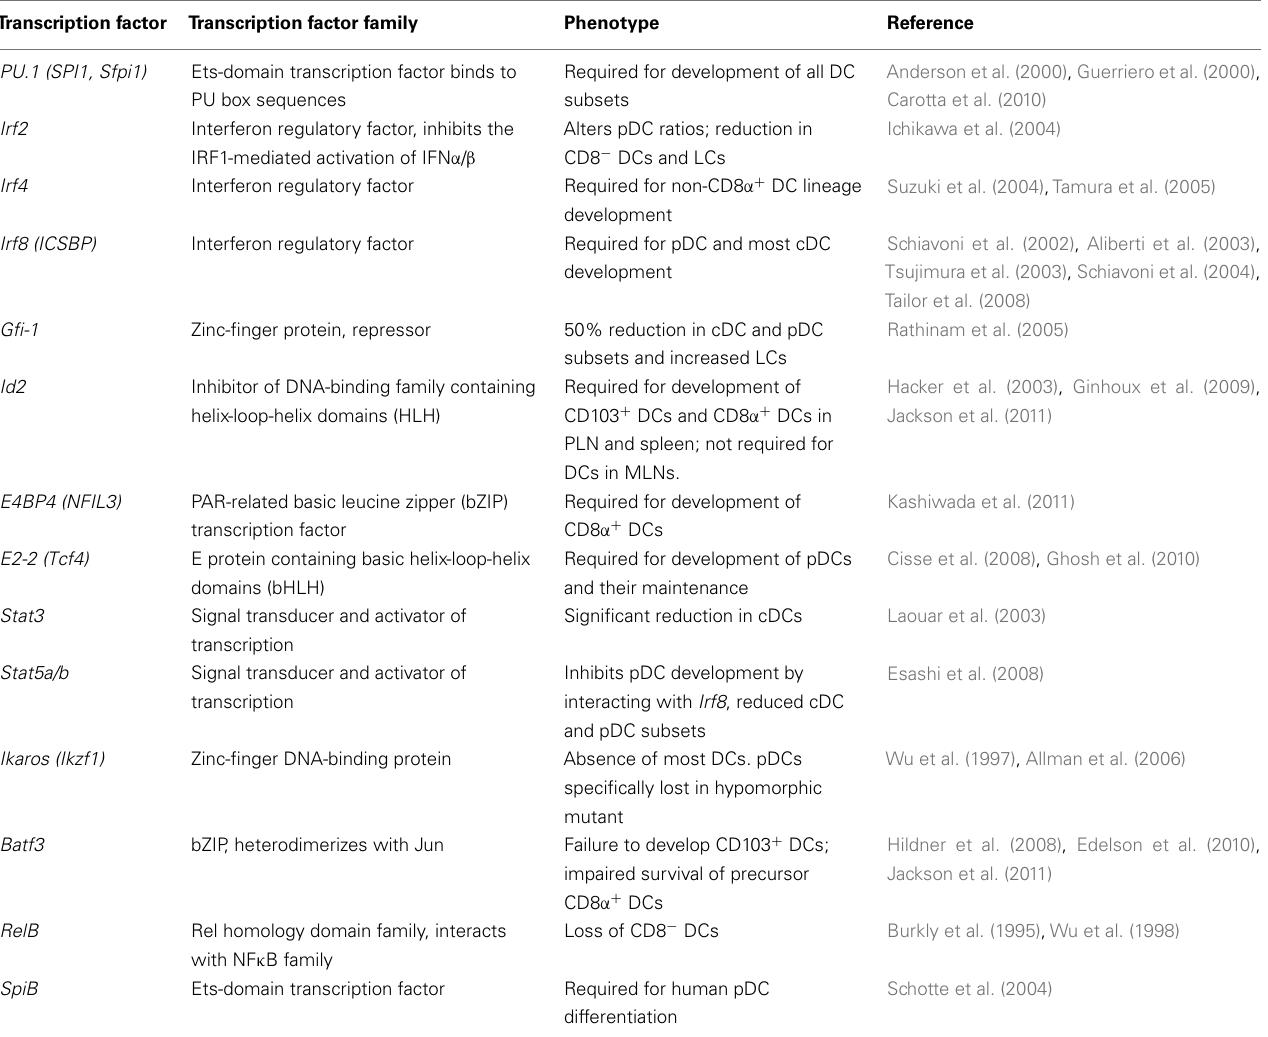
Table 2 |Transcription factors guiding steady-state DC subset